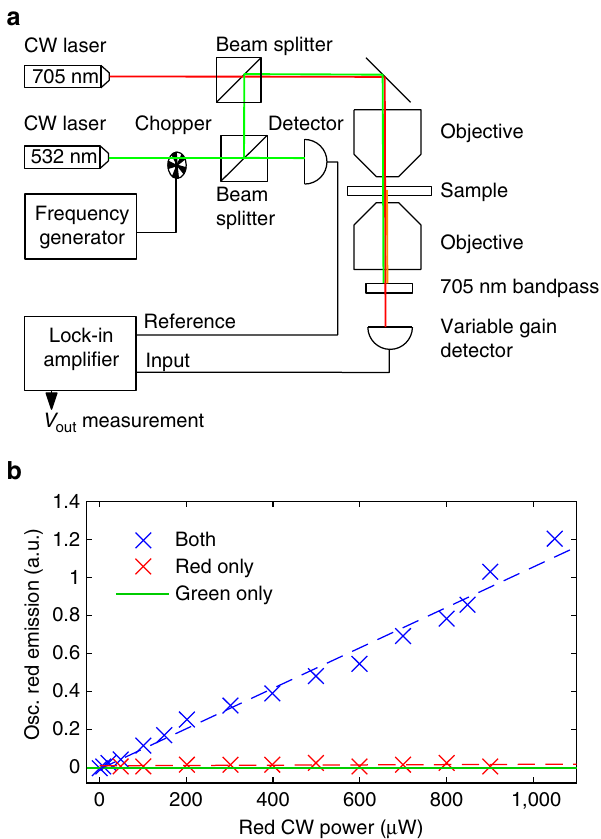
Figure 5 | Direct measurement of stimulated emission. ( a ) Setup with modulation on the green laser and a lock-in amplifier filtering the detection signal for only the modulation frequency ( b ) The red CW laser creates stimulated emission. Because the stimulated emission is dependent on the green pump laser, it also oscillates at the modulation frequency and is hence detected. The red CW laser signal itself is unmodulated and is thus filtered out by the lock-in amplifier. The green laser by itself creates fluorescence, which is almost entirely filtered out by the 705nm bandpass and additionally only the fraction that is emitted into the solid angle of the objective is directed to the detector. The stimulated emission is emitted into the laser beam direction and is thus entirely collected by the detector and gives a clear signal linear with stimulating power. The blue and red dashed lines are linear